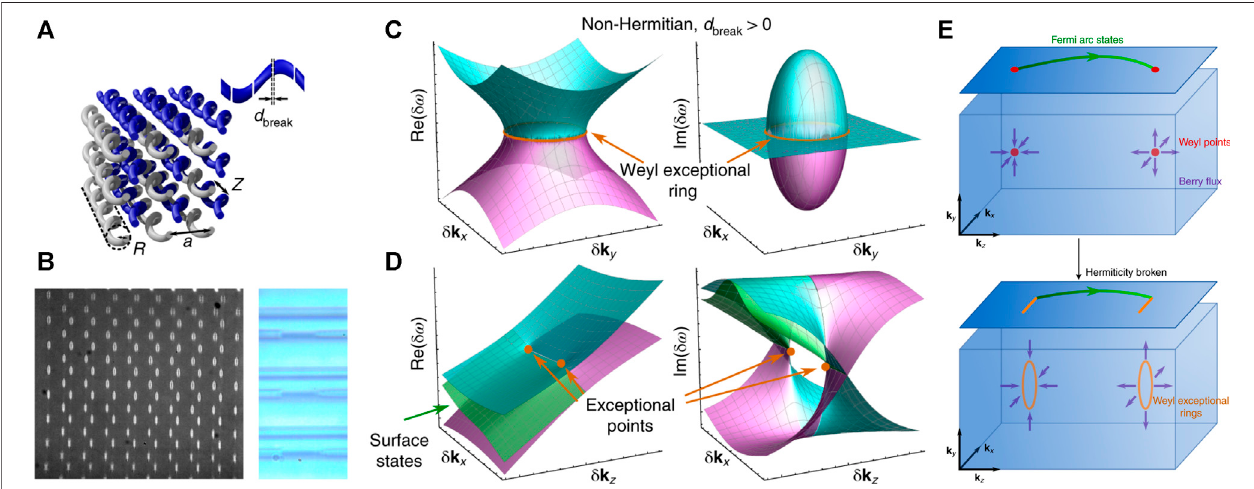
FIGURE 8 | (A) Bipartite helical waveguide array, where breaks have been added to one of the sublattices to remove the Hermiticity [90]. (B) Image of the output facet (left) and microscope image showing breaks added (right) . (C) Band structures in the δ k x − δ k y plane possessing a Weyl nodal ring. (D) Band structures in